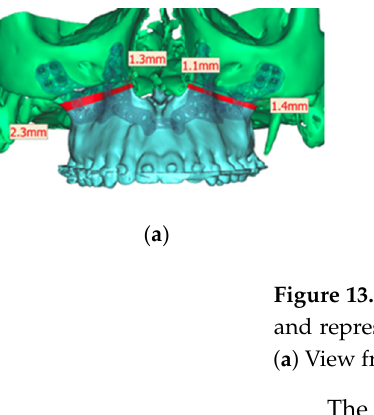
The profile analysis showed a pre-operative SNA angle of 86.5 ◦ . An angle of 99.9 ◦ had